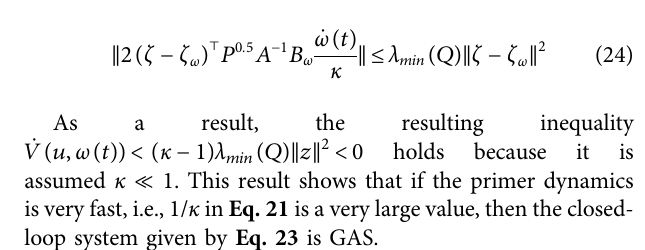
FIGURE9| Illustratesthestatevaluesand forces duringwalkingand jumpingfeatssimulatedwithHarpy ’ s3Dfull-dynamics. Thereferencejointtrajectories( z 0 )are manipulated ( z ω ) such that the applied constraint equations do not violate the constraint as shown at t (cid:2) [9.5, 11.5]s.